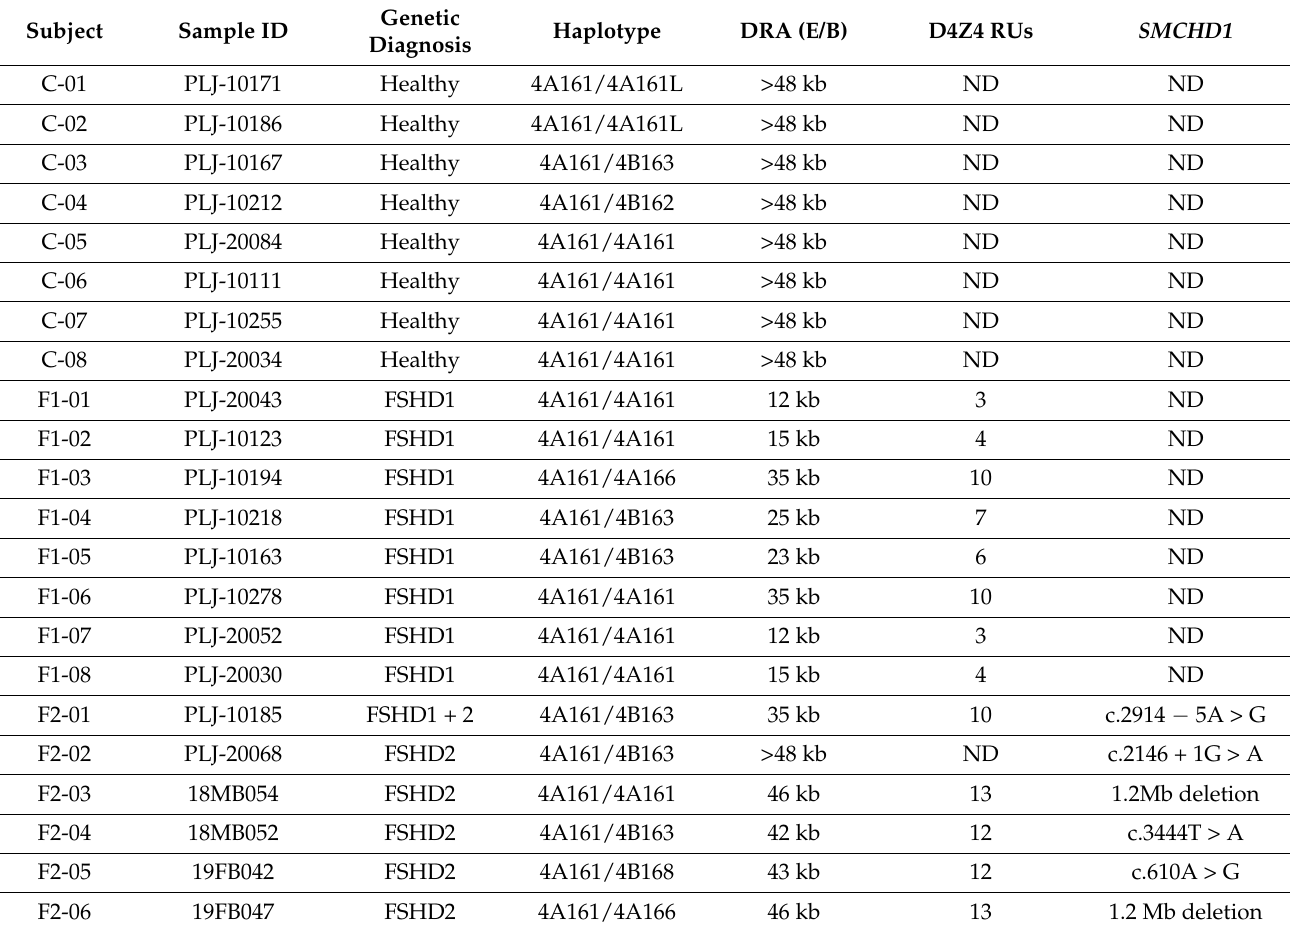
Table 1. Genetic characterization of the samples used in the